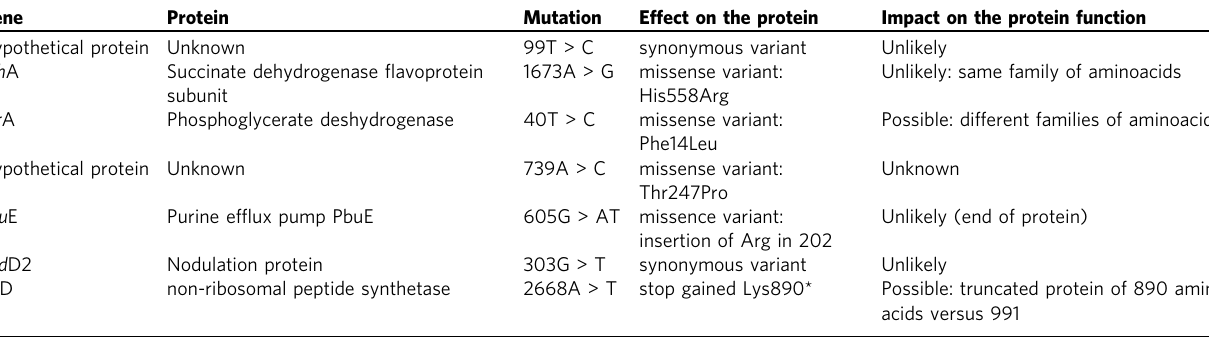
Variant calling was performed using the Snippy software (https://github.com/tseemann/snippy) after annotation of the reference genome of morphotype n°1 (Prokka software).